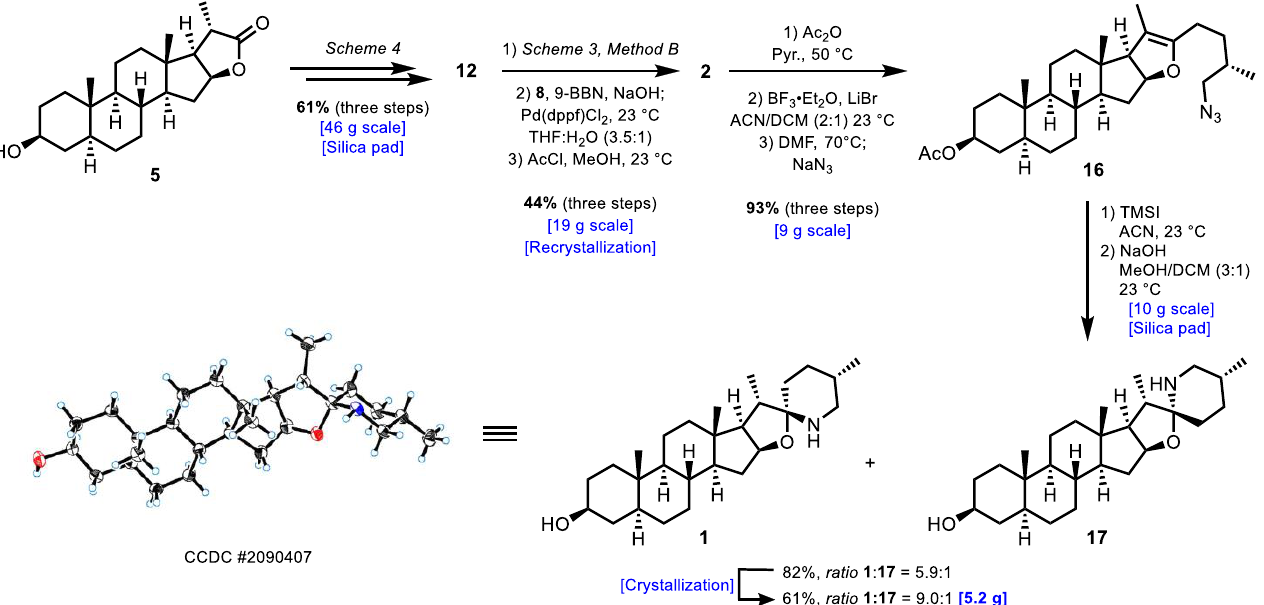
Scheme 5. Streamlined chemical steps and ORTEP diagram of 1